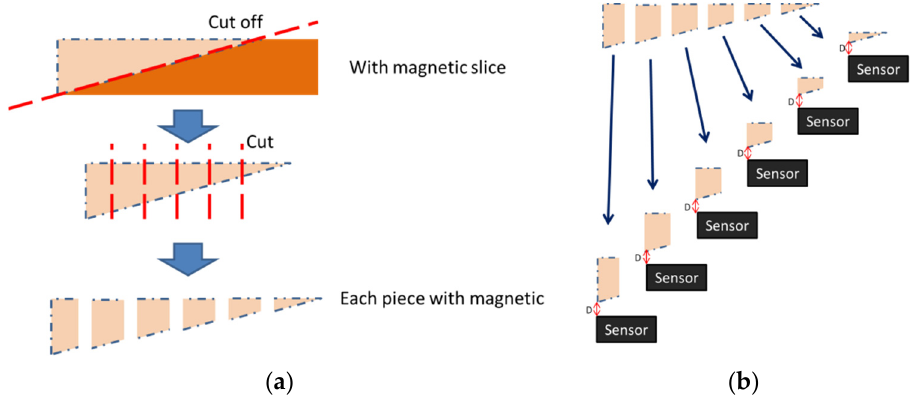
Figure 7. Tire slice verification: ( a ) the tire slice cut into six pieces; ( b ) radial wave. The strategy used a rubber piece with a magnet to simulate the magnetic field. The rubber was put in the same position as the tire slice. Figure 8 shows the method of measuring the magnetic field. The rubber was then put onto the tire slice. The method used rubber slices with different thicknesses to generate different magnetic fields. The Hall sensor can obtain different values according to the different magnetic forces. The thickness of T1 was larger than T2. The strategy delivered two results. First, the method verified the magnetic field trend without the tire slices to ensure that the rubber pieces had a magnetic field and that the trend was related to the thickness. Second, the method verified the magnetic field trend with the tire slice. The magnetic field was affected by the medium, as expected, because the tire slice has a steel belt layer. Some degree of the magnetic field is masked by the steel belt layer, which reduces the magnetic field strength. Therefore, the value of the magnetic field sensed by the Hall sensor will decrease; this is also predictable. We discuss the results in the next section.